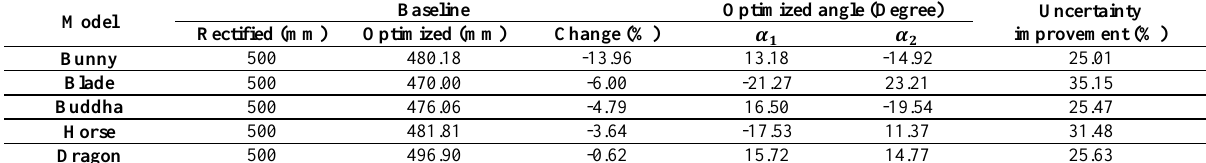
Table 1. Comparison between rectified and optimized camera setups in changing of baseline and improvement in depth estimation uncertainty for five 3D models. The minus sign in the baseline change column means reduction in the baseline.